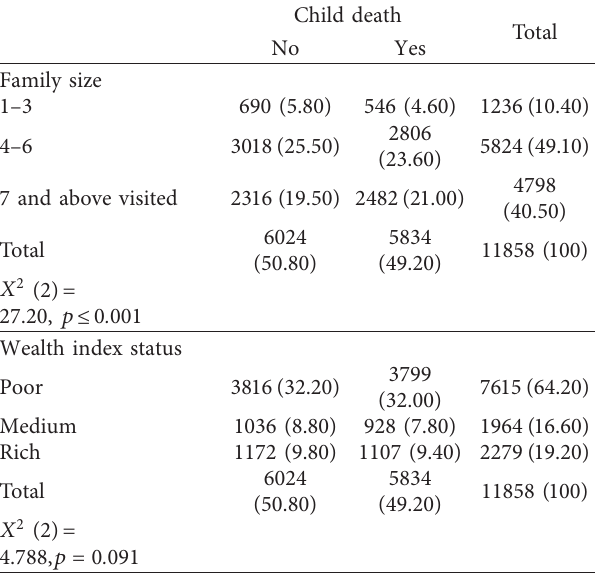
Table 14: Family size and wealth index on child